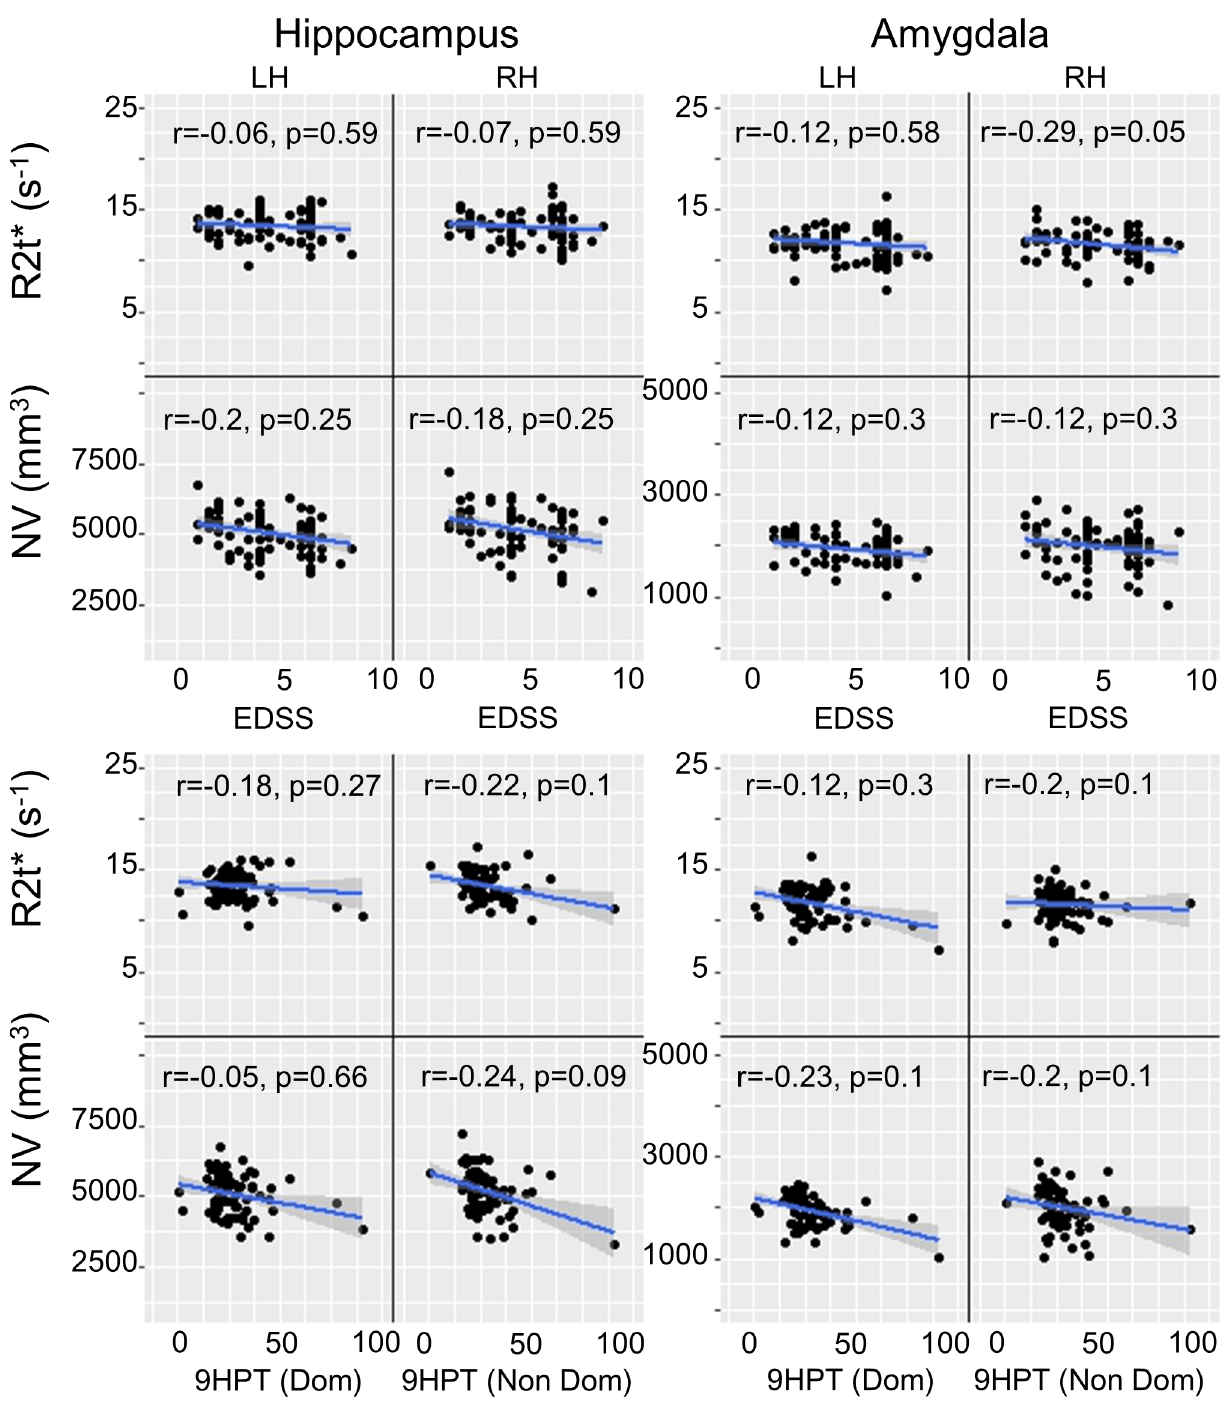
Fig 6. Correlations of R2t * and NV with clinical disability scores (EDSS, 9HPT of dominant and non-dominant hands) in hippocampus and amygdala of MS patients. The correlations(r) and p-values (with FDR correction) are providedin each panel. LH = Left Hemisphere; RH = Right